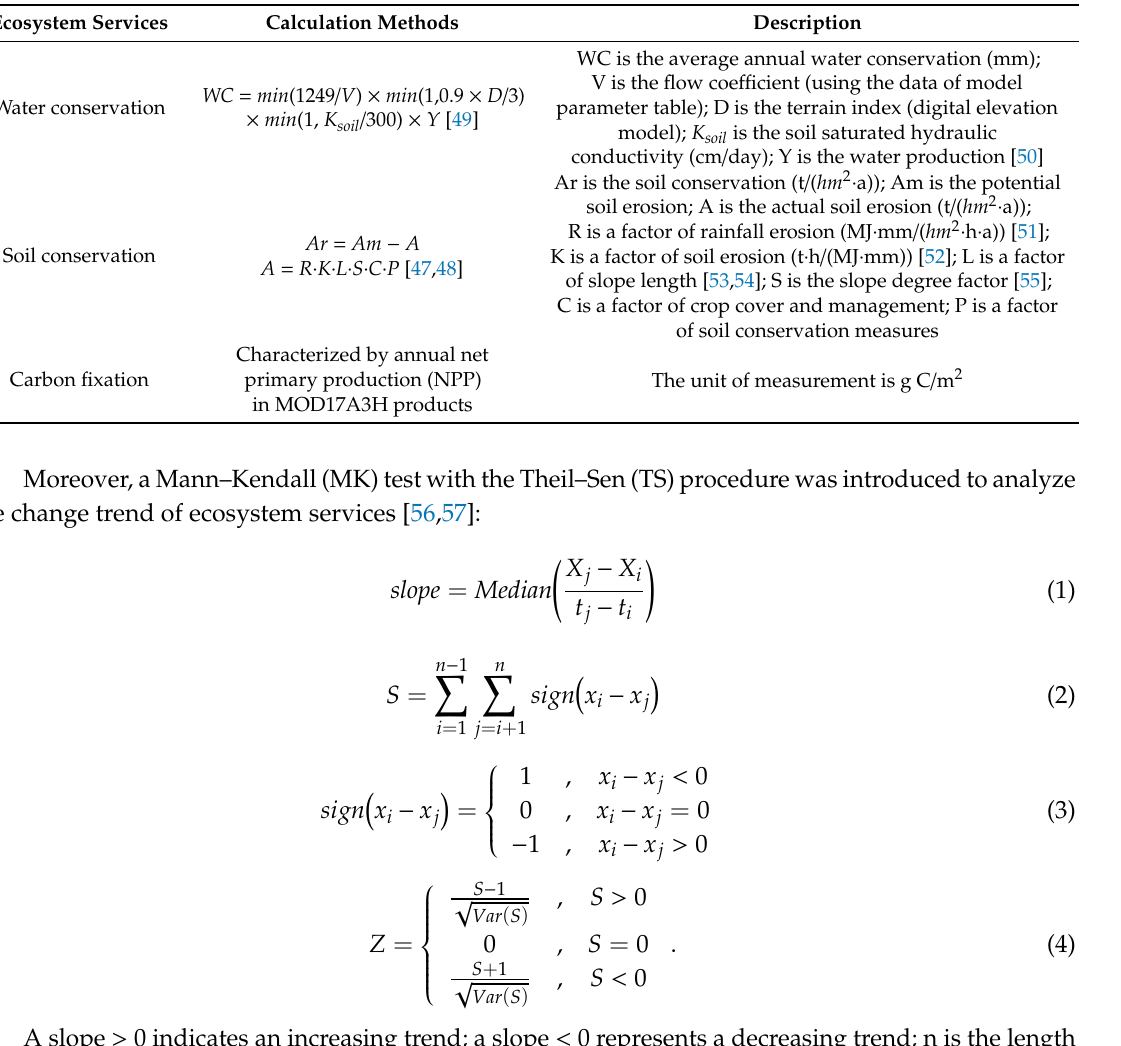
Table 2. Ecosystem services calculation